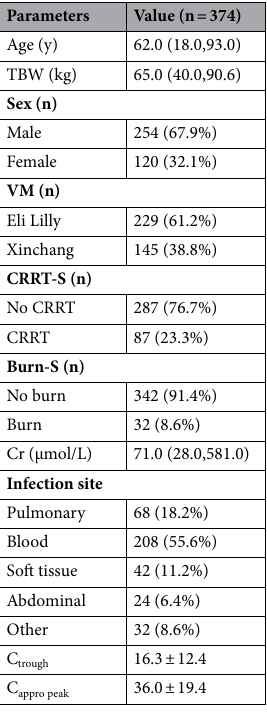
Table 6 summarized the results of the basic and final population models. All the parameters of the final were reliably predicted, since the percentage of relative standard estimated error was less than 40%.The population coefficient of variation decreased from 53.27% and 43.15% to 41.72% and 35.14% from the basic to the final model for CL and V, respectively. The individualized heterogeneity increased from 25.72% and 37.31% to 56.01%